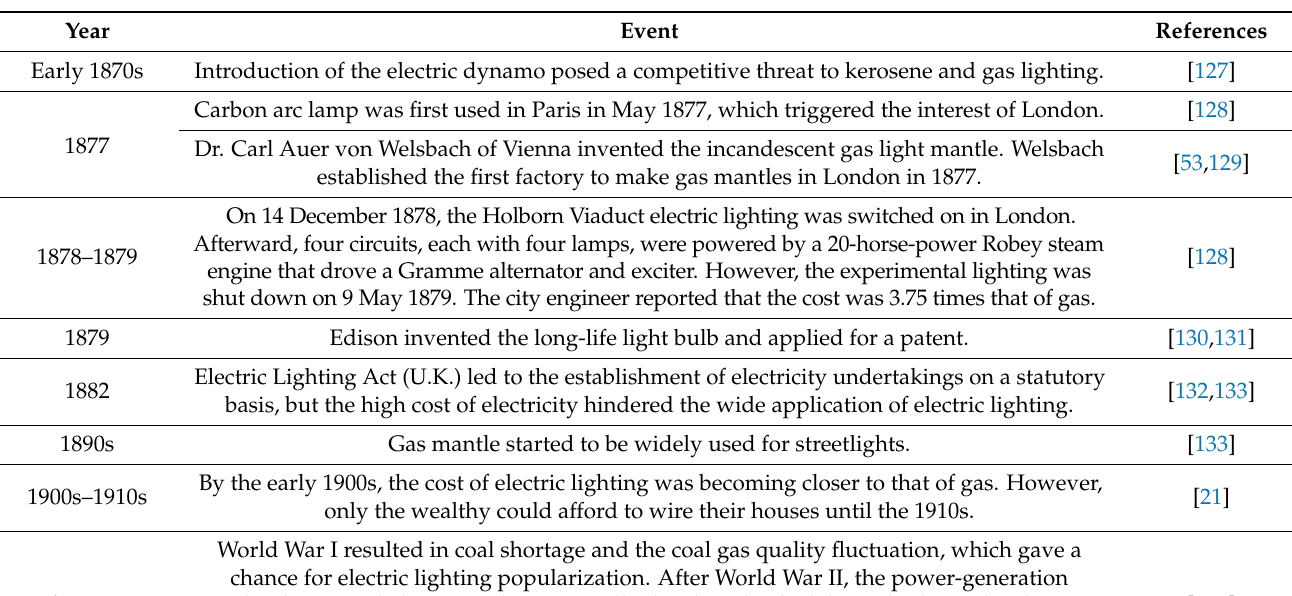
Table 10. Lighting system development path since the